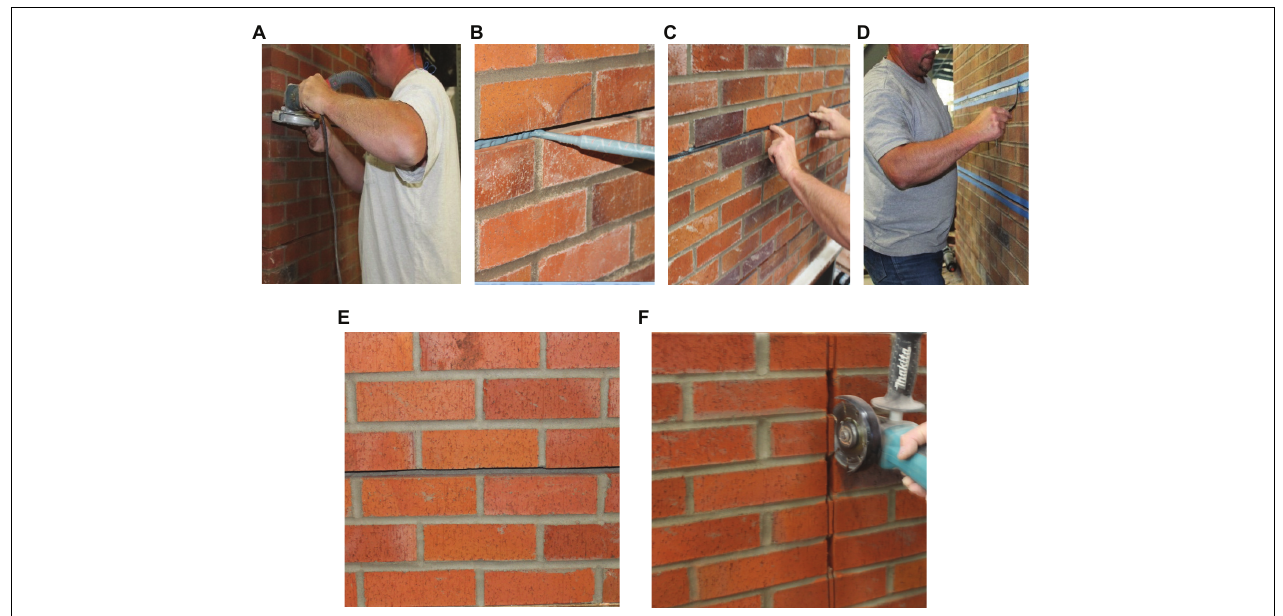
FIGURE 1 | Retrofit steps: (A) saw cutting grooves, (B) partial filling of grooves with epoxy, (C) placing and pressing steel reinforcing bars into the groves with the first layer of epoxy, and (D) filling and surface finishing of grooves, (E) horizontal cut through the bed joint, and (F) vertical cut through the bricks and the head joints.